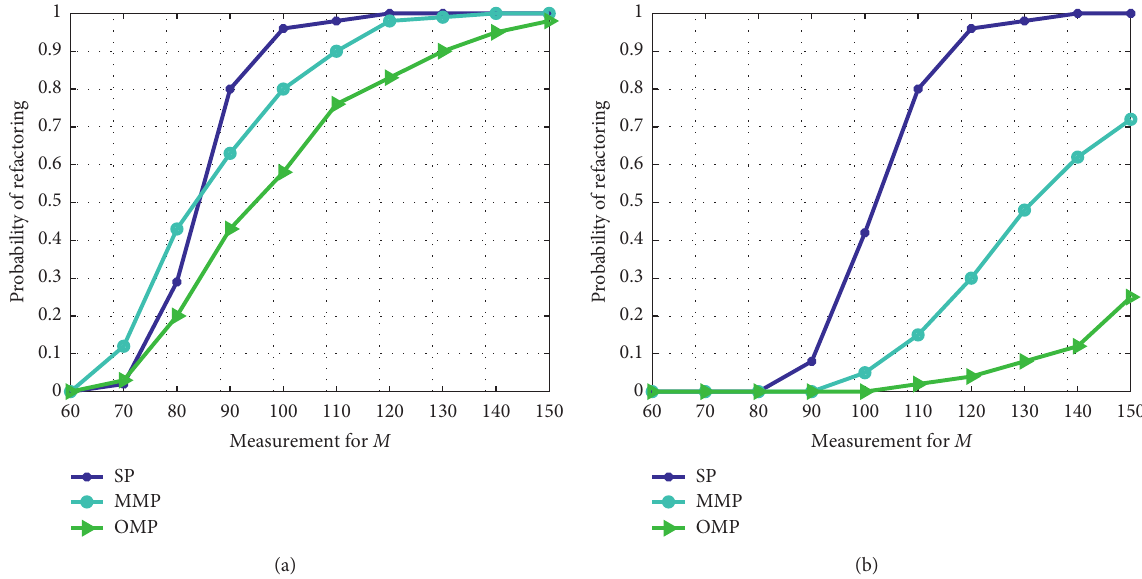
Figure 5: Variation of reconstruction probability of different greedy reconstruction algorithms with measured number M. (a) Gaussian signal. (b) 0-1